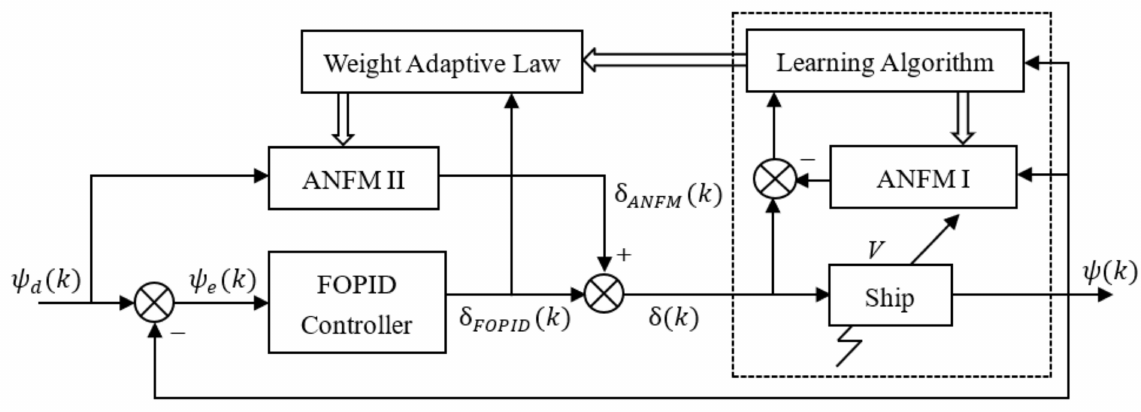
Figure 7. ANF-FOPID control